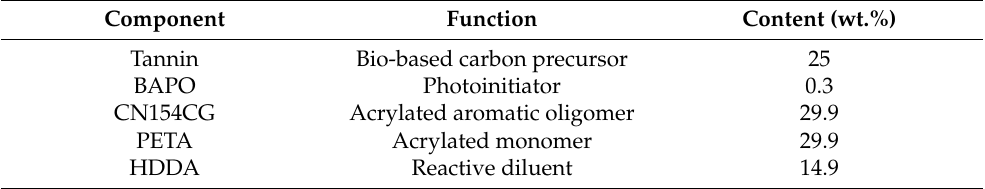
Table 1. Representative example of acrylate-resin formulation for 3D printing by SLA. Component